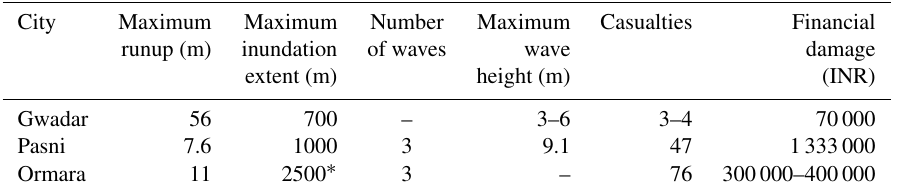
Table 2. Impact of 1945 Makran tsunami along the coastal cities of